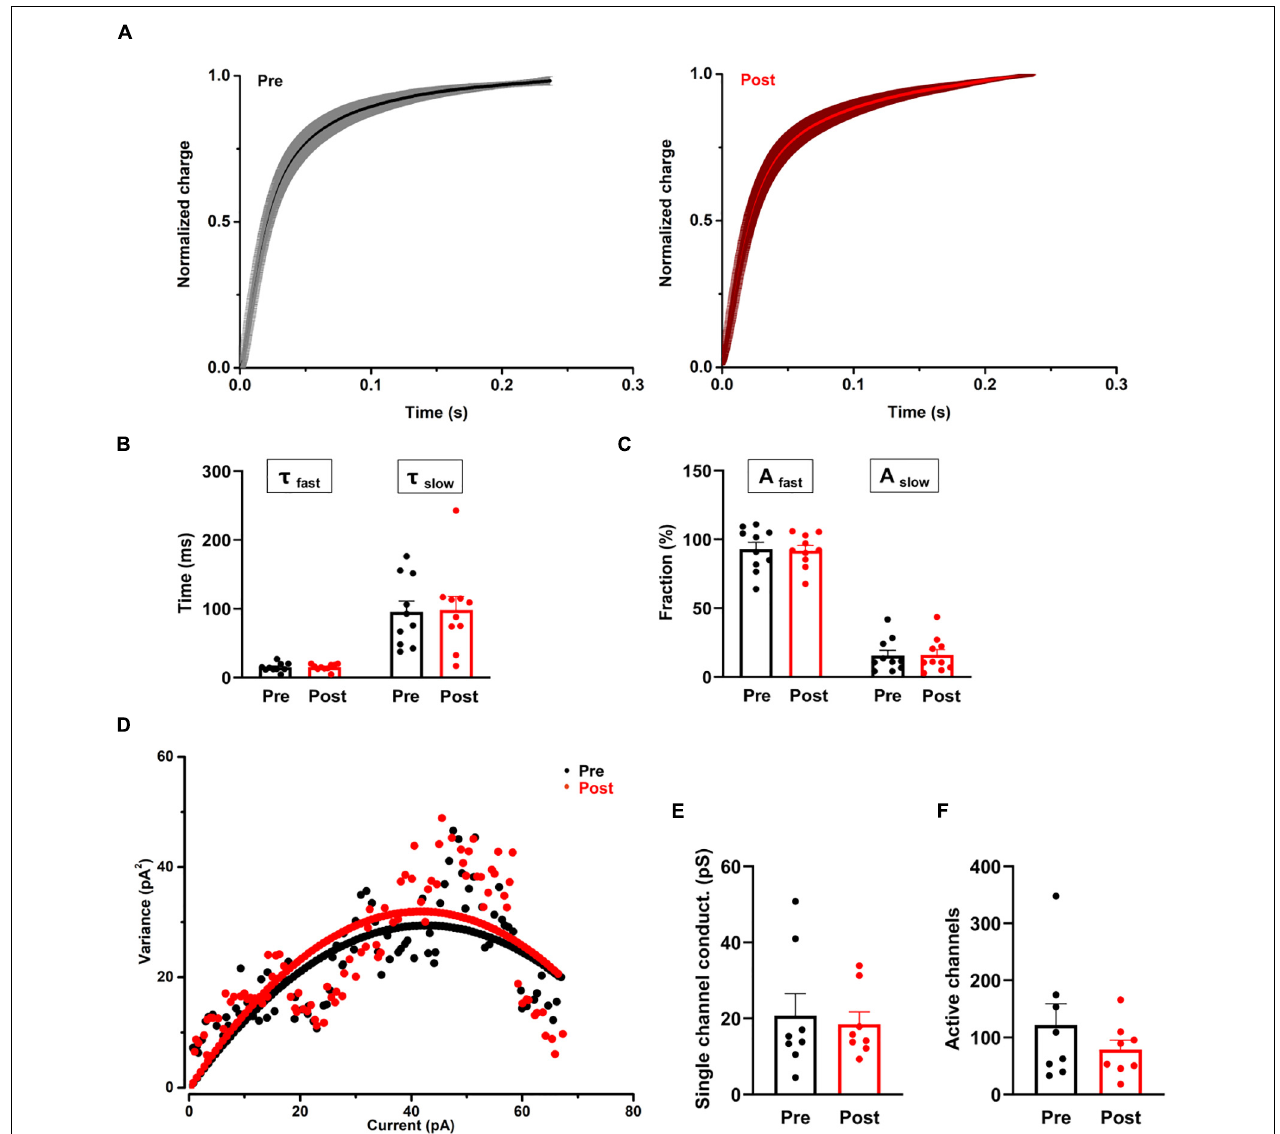
FIGURE 4 | The effect of proanthocyanidins on the kinetic properties of the synaptic transmission of PBN-projecting neurons in the spinal dorsal horn. (A–C) Application of proanthocyanidins did not change the fast ( τ fast ) and slow ( τ slow ) decay time constants and the fast (A fast ) and slow (A slow ) fraction constituent in the TMR-positive spinal cord neurons. (D–F) The non-stationary fluctuation analysis (NSFA) indicated that bath application of proanthocyanidins affected neither the single channel conductance nor the AMPAR channel number in the TMR-positive spinal cord neurons.